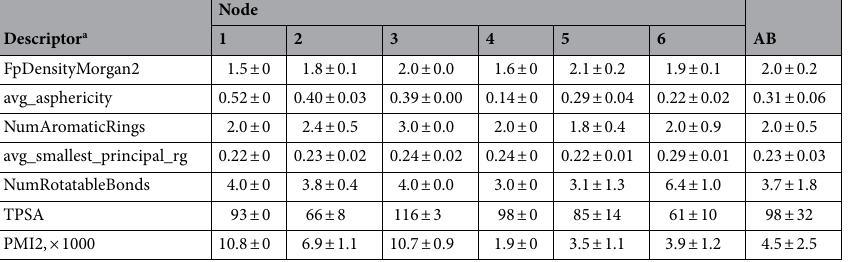
Table 3. Values of top descriptors in the center of permeation nodes and their comparison to antibiotics. a See Table S3 for definitions.